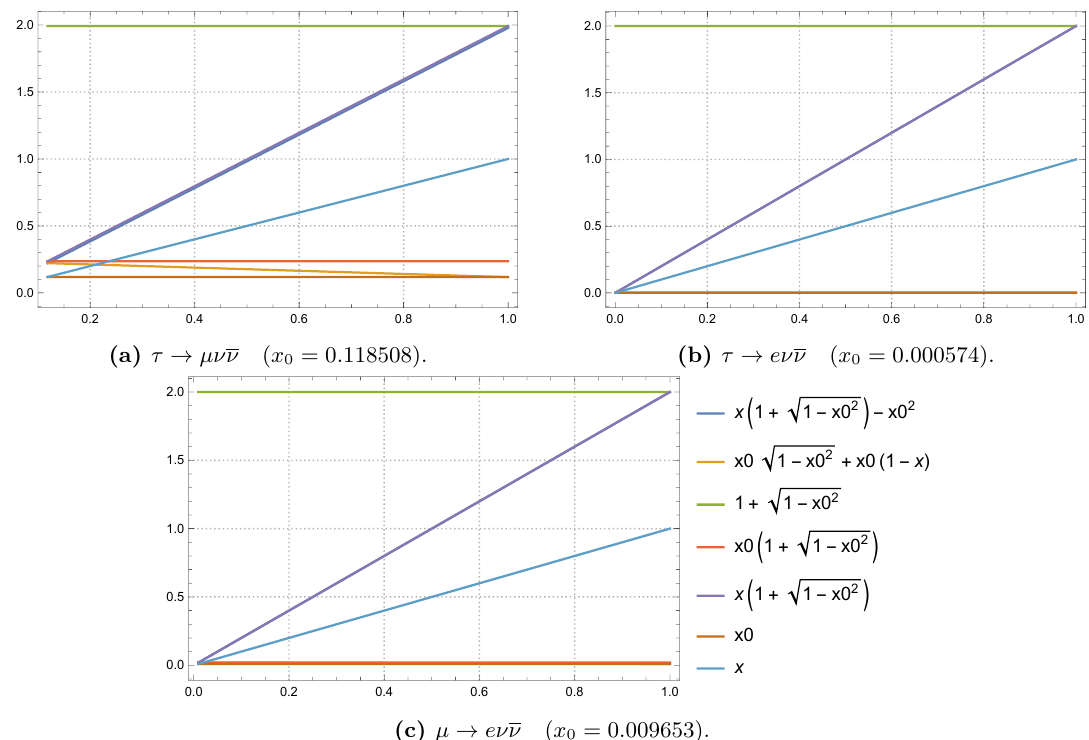
Figure 2. Different phase space structures for the leptonic differential decay rate ( x 0 < x < 1